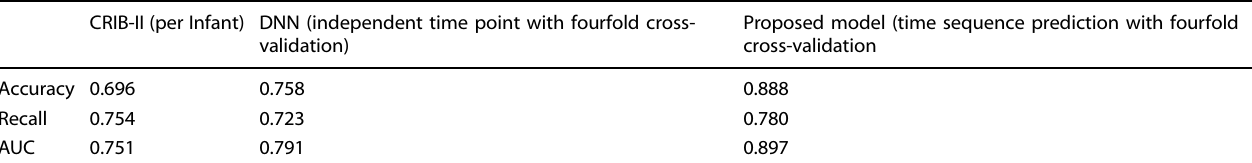
Table 11. Performance comparison of CRIB-II, DNN, and proposed model. CRIB-II (per Infant) DNN (independent time point with fourfold cross- validation)